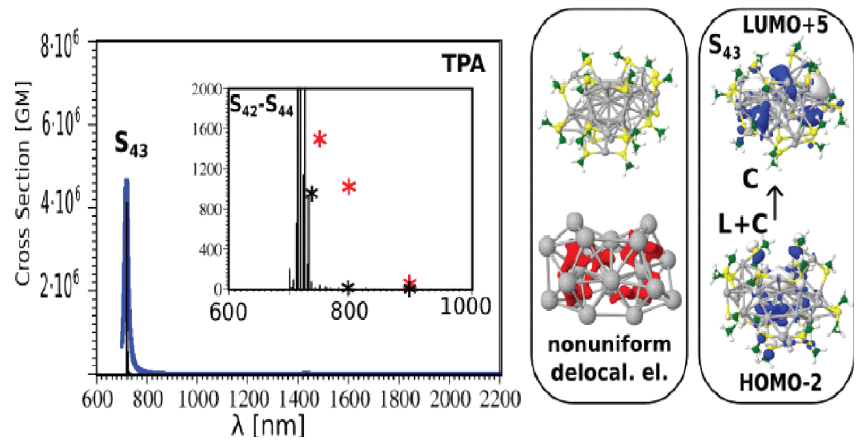
Figure 5. TDDFT TPA absorption spectrum (and experimental values in insets, red crosses) and molecular orbitals involved in transitions for Ag 31 (SCH3) 19 nanoclusters (right side). Giant TPA cross-sections have been reported.